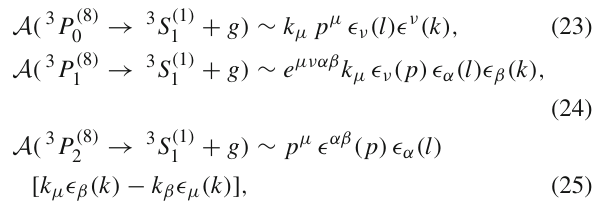
such a transition (cid:11) O h [ n ] (cid:12) . Eventually, the production